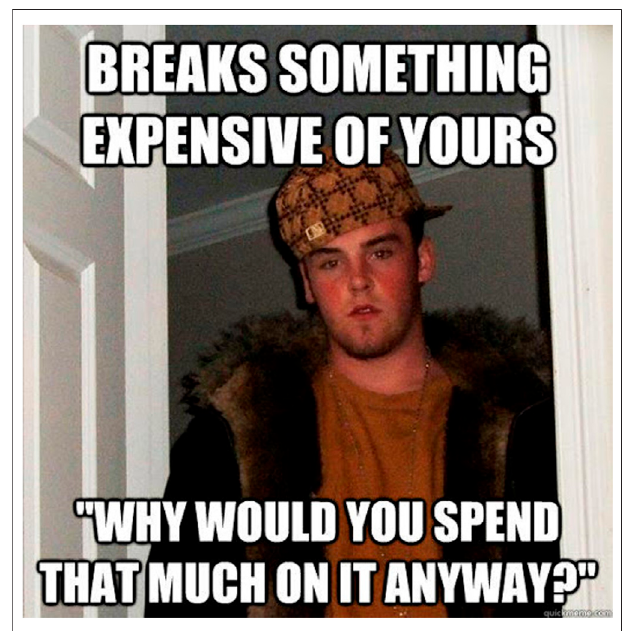
FIGURE 6 | An example of a Scumbag Steve meme.